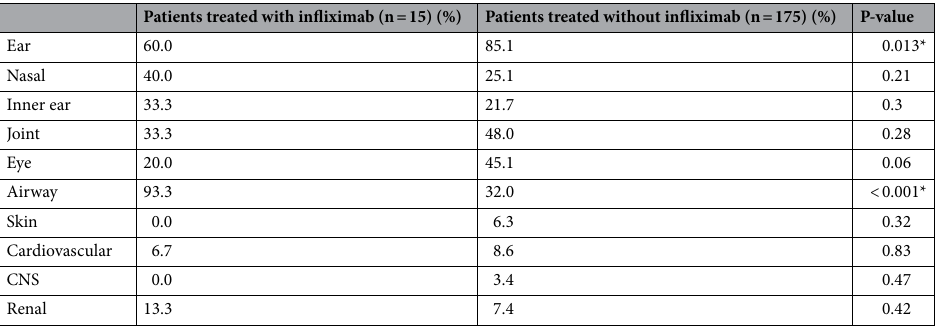
Table 2. Clinical characteristics of RP patients treated with infliximab in 2019 survey (n = 190). *Significant differences were observed (P <